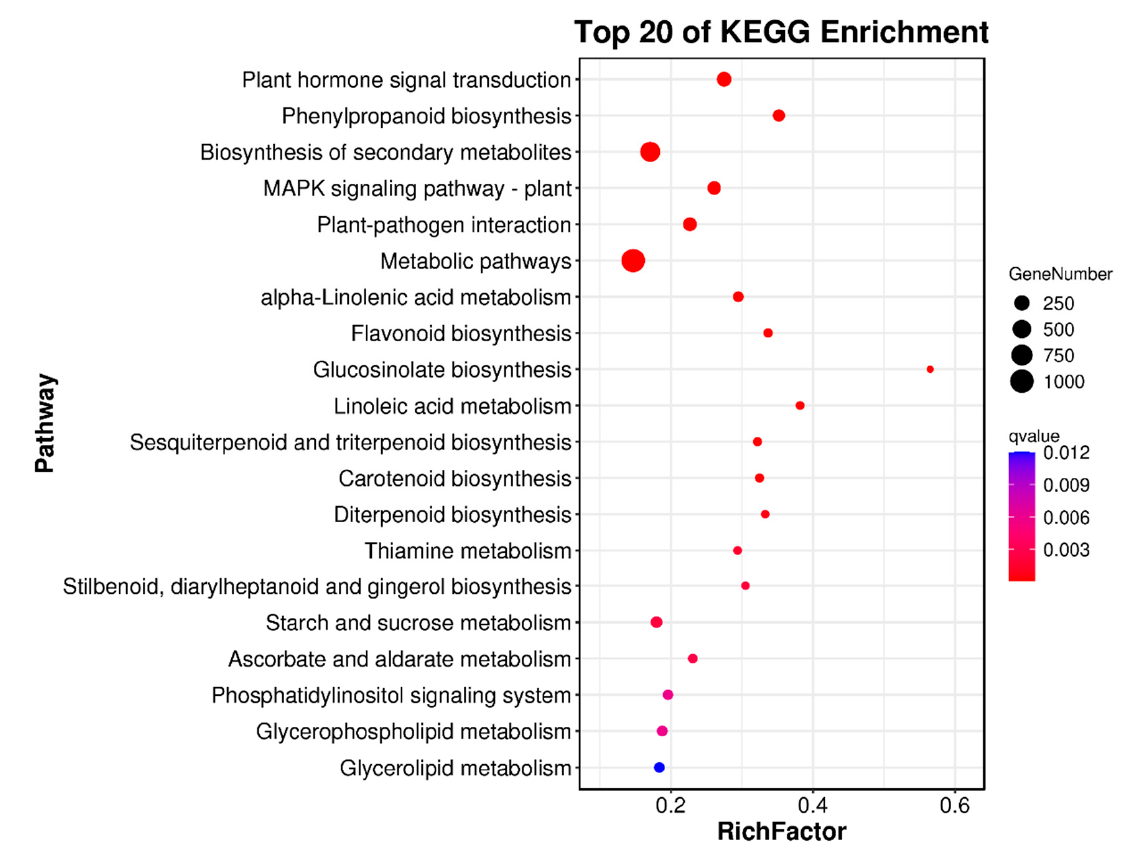
Figure 5. Bubble plot of differential genes enrichment for G vs R cultivars. The top 20 pathways with the smallest Q values were used to construct the graph. KEGG enrichment of DEGs among different roselle cultivars. The “X” axis shows the enrichment score; the “Y” axis shows the number of DEGs mapped to each KEGG pathway.